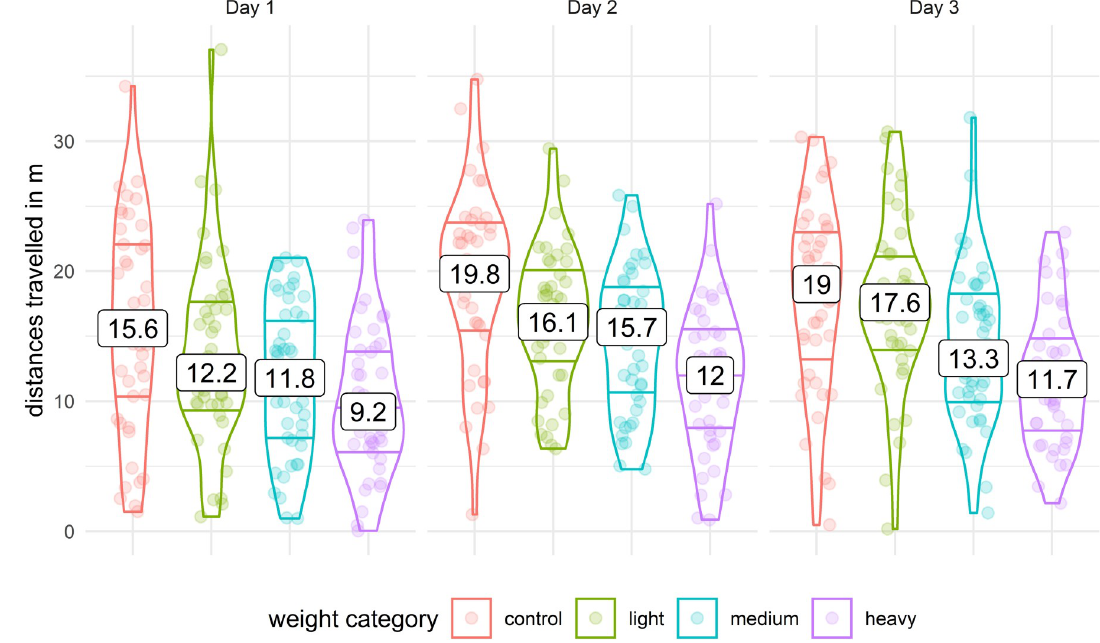
Fig 4. Distribution of distances travelled ( movementSum ) by crickets carrying no tags (control) or carrying light, medium, or heavy tags over 3 consecutive days without regard to temperature. The bottom horizontal lines represent the 1st quartiles, the boxes in the middle indicate the medians, and top horizontal lines represent the 3rd